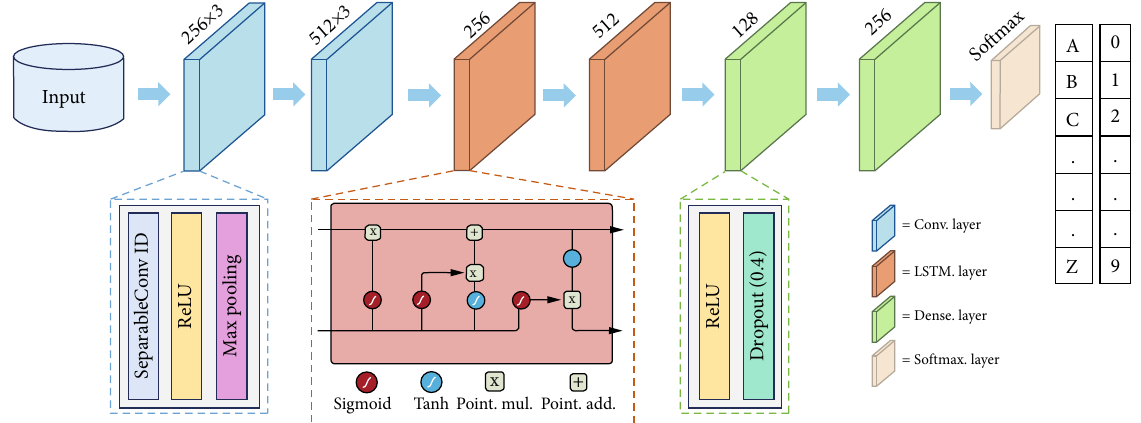
Figure 4: The proposed TARNet architecture.